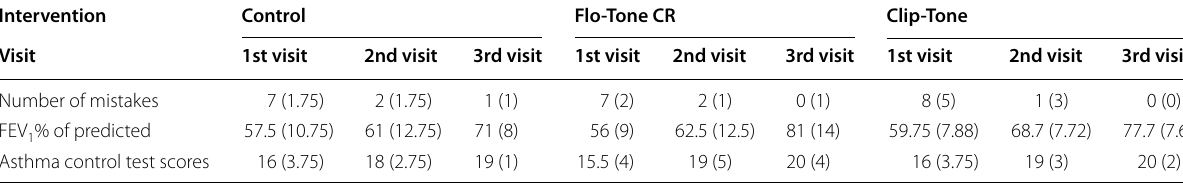
Outcomes of subjects are reported as median (Interquartile range)